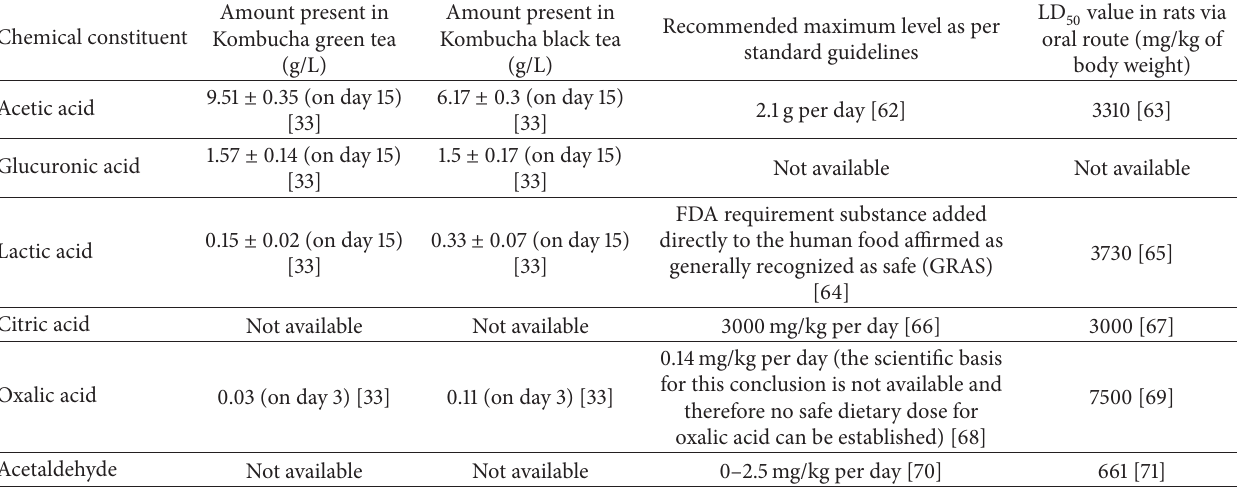
Table 2: Some constituents of Kombucha related to health claims and their recommended values for